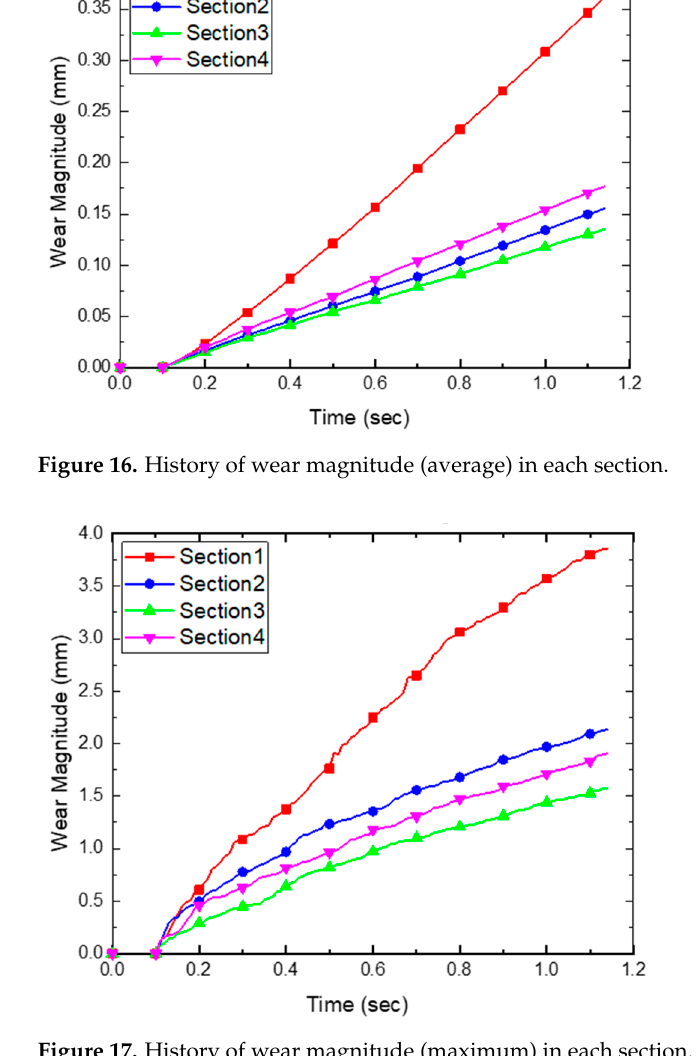
Figure 18. History of wear magnitude (total) in each section.